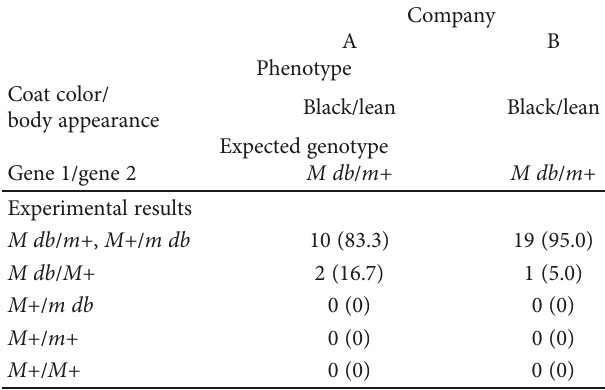
Table 1: DNA diagnosis of mice purchased from